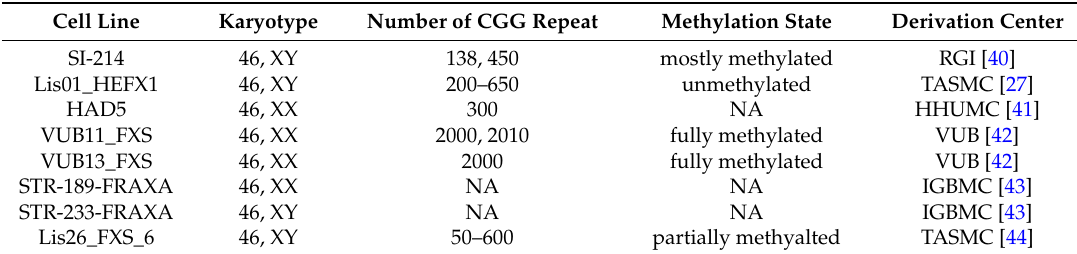
Table 1. Fragile X syndrome (FXS) Human embryonic stem cell